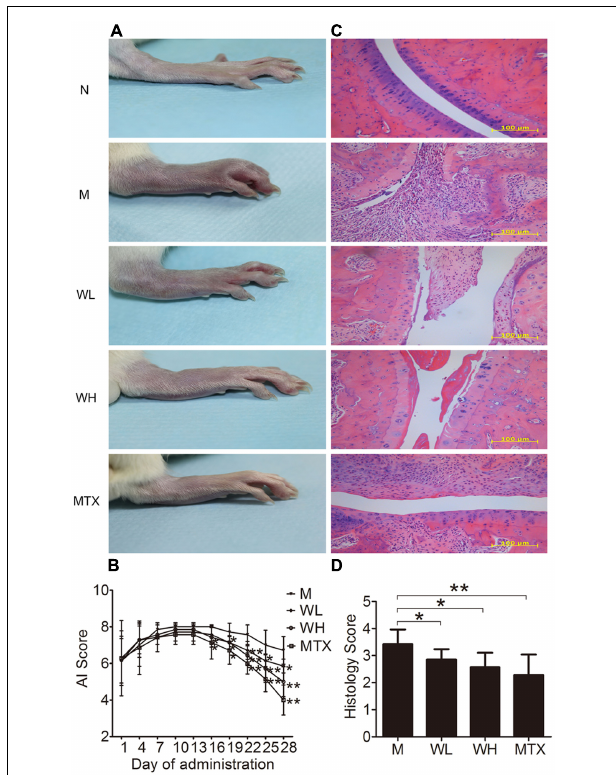
FIGURE 5 | Effects of WTD on arthritis severity of CIA rats. (A) Representative photograph of ankle joint from each group. These photos were taken on the last day of treatment. (B) AI score of each group. ∗ P < 0.05, ∗∗ P < 0.01 vs. model group. (C) Representative histological finding of ankle joint from each group. Tissue sections from ankle joints were stained with H&E. Original magnification 200 × . (D) Histological score in each group. ∗ P < 0.05, ∗∗ P < 0.01 vs. model group. Abbreviations: N, normal group; M, model group; WL, Wu-Tou decoction low dose group (3.75 g/kg/d); WH, Wu-Tou decoction high dose group (7.5 g/kg/d); MTX, methotrexate group (1 mg/kg/w).